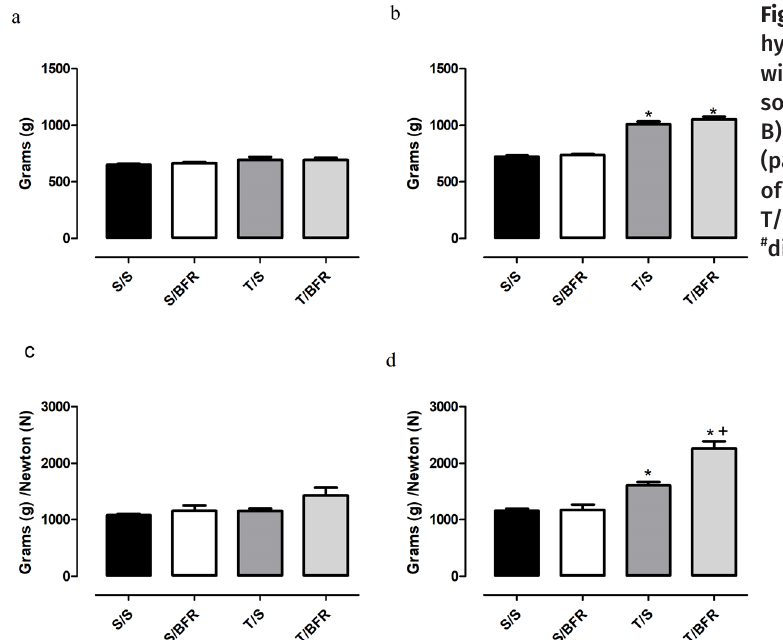
Figure 4. Skeletal muscle hypertrophy index of the paw with restriction surgery (right) soleus (panel A), plantar (panel B) and gastrocnemius muscles (panel C), corrected by the length of the tibia of groups: S/S, S/BFR, T/S and T/BFR. *different to S/S; # different to T/S. p <